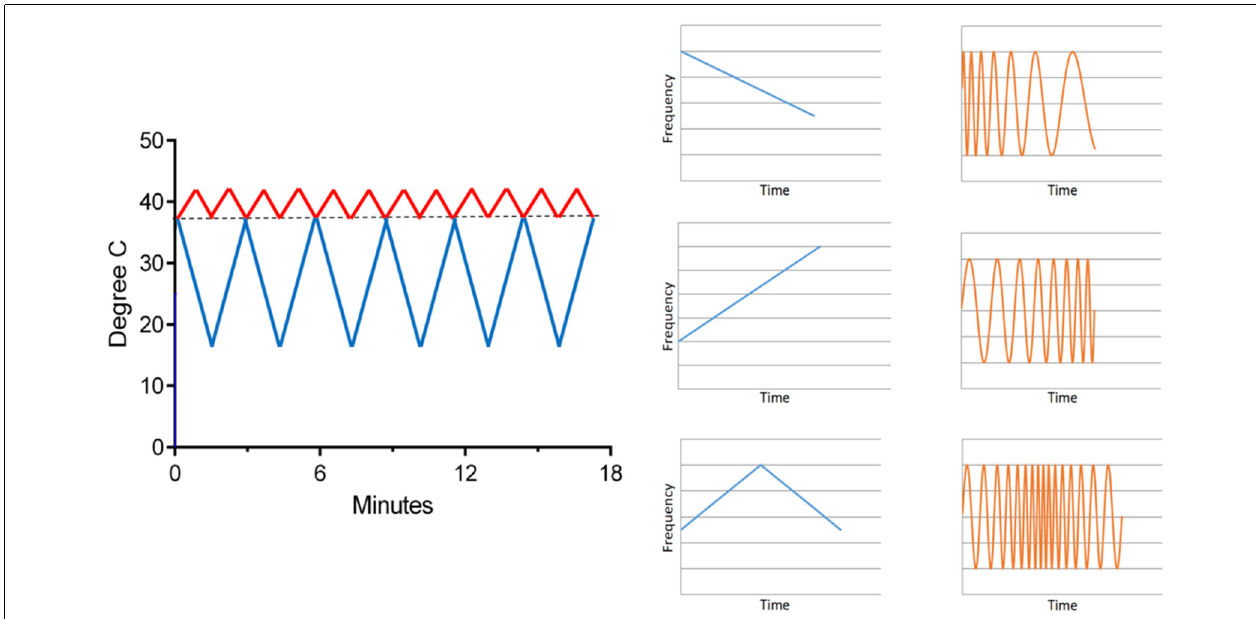
FIGURE 8 | An example of time-varying waveforms used with the solid-state CVS device (left). One ear receives a warm triangle wave and the other a cold triangle wave. As seen in Figure 5 , warming increases the afferent firing rate and cooling decreases it. On the right, the effect of a time-varying temperature on the hair cell firing rate is shown graphically. The response (orange) frequency shifts in time, a phenomenon called a “chirp.” Thus, a complex range of firing rate modulations can be achieved.